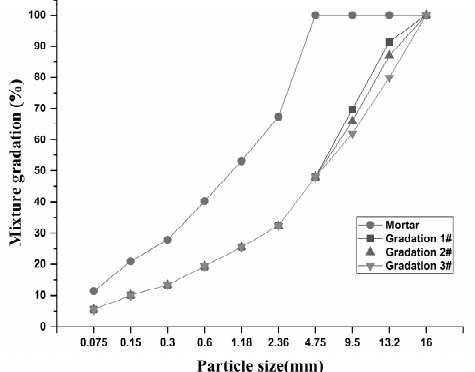
Figure 1. The gradation of the asphalt concrete and asphalt